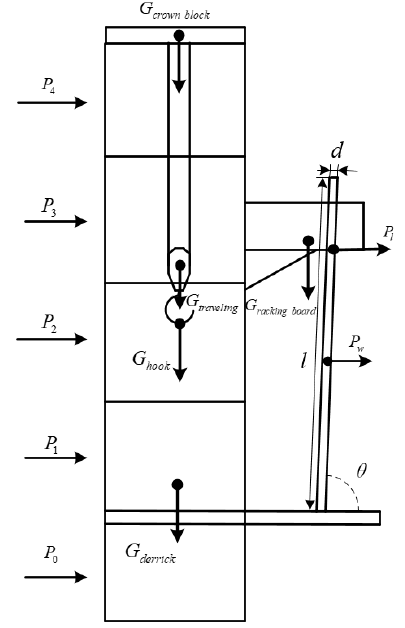
Figure 1. Simple mechanical analysis diagram of derrick.